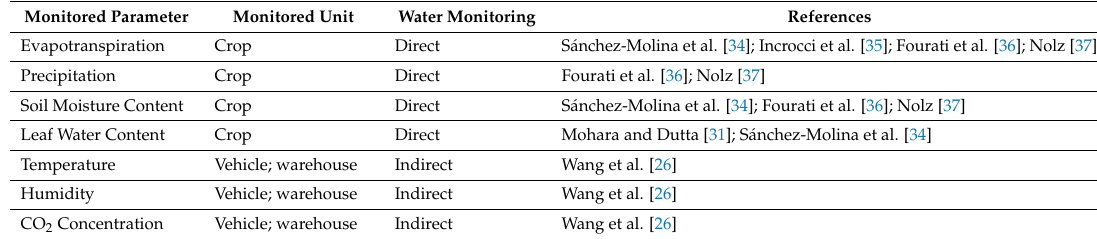
Table 2. Categorization of sensors for water